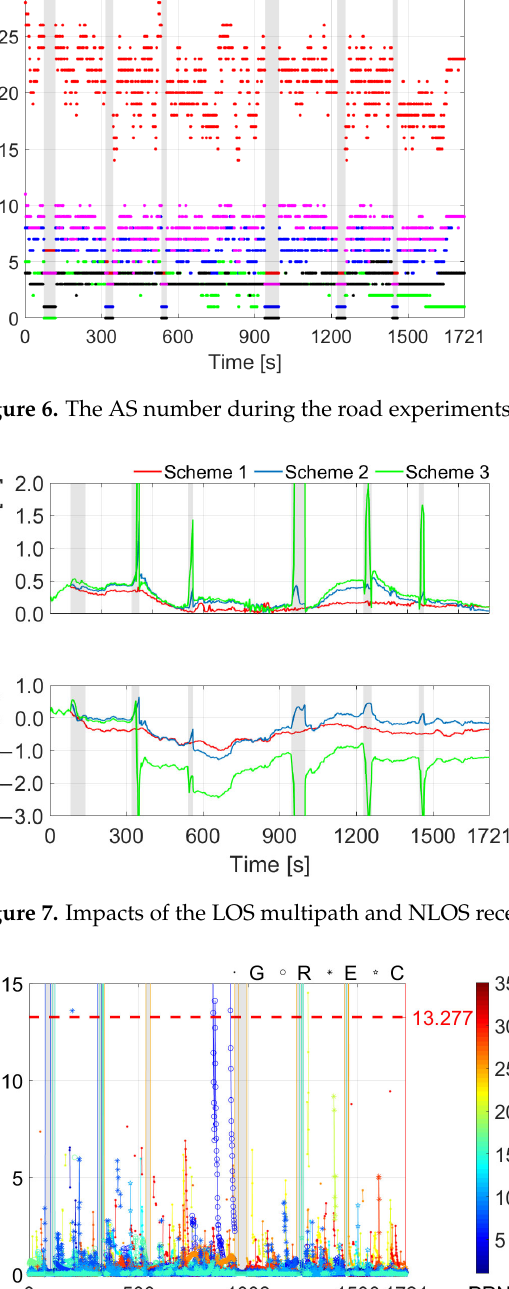
Figure 8. Chi ‐ square statistics during the road experiment. In the proposed SSTRKF, the sequential Student’s t ‐ based Kalman filter is activated to process the observations that cannot be appropriately weighted by the IGG ‐ III model. According to Section 4.3, 𝑝 (cid:3038) , (cid:3036) (cid:4666)(cid:2868)(cid:4667) and 𝑞 (cid:3038) , (cid:3036) (cid:4666)(cid:2868)(cid:4667) were initialized to 0.3 and 1 before processing every observation, respectively. The maximum iteration number of the SSTRKF was set to 10 [17–19]. To explore the superiority of the proposed SSTRKF, the KF, the RKF, the SSTRKF, and the STKF were applied to the multi ‐ GNSS PPP/INS tightly coupled system in the Scheme 3 setting. Figure 9 shows the KF, the RKF, the STKF, and the SSTRKF positioning errors during the road experiments. The STKF simultaneously tunes the observation noise covariance